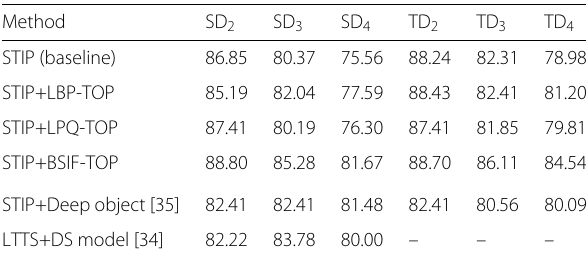
Table 1 Recognition accuracy (%) of various STIP-based approaches in comparison with other approaches on downsampled versions of the KTH dataset Method